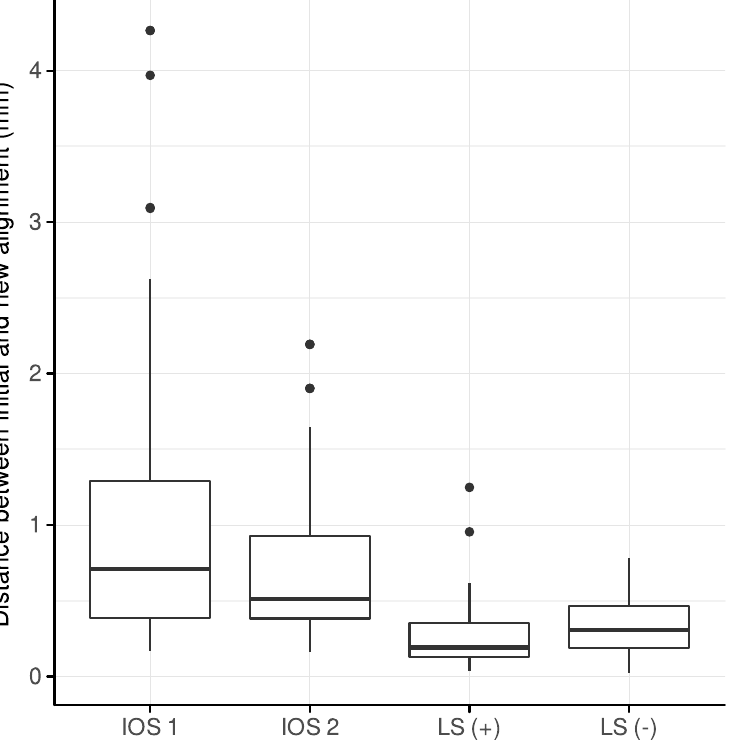
Figure 3. Reduction of the interocclusal distance between initially and newly aligned scans per scanner group.